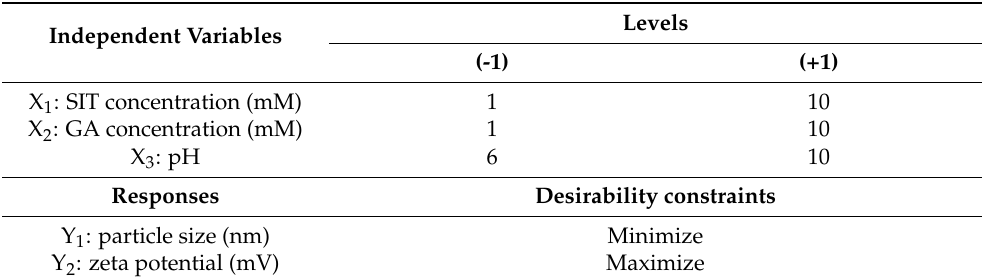
Table 4. Independent variables and responses used in a 2 3 full factorial experimental design for the formulation and optimization of SIT-GA